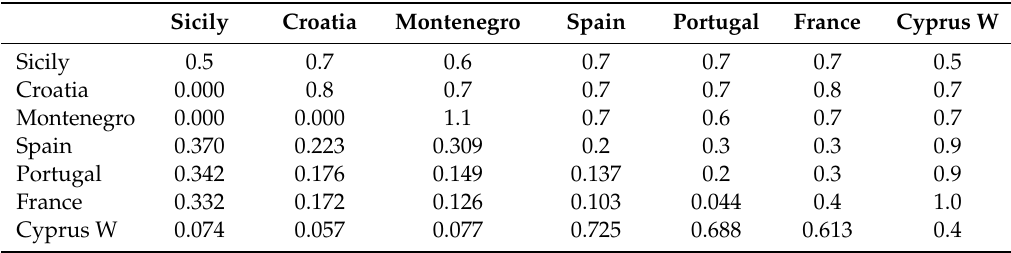
Table 4. Mean genetic distances between Gobius cruentatus populations for cytochrome b (uncorrected p-distances, in %, above diagonal), intrapopulation distances (on diagonal), and pairwise F STs (below diagonal). None of the values of F STs was significant at α = 0.05 / number of